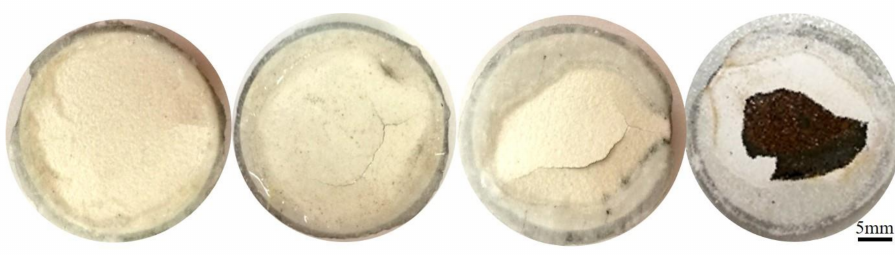
Figure 6. The corrosion process of the coating in hydrochloric acid immersion corrosion.